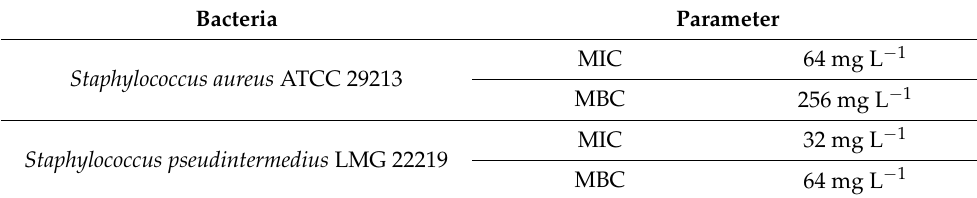
Table 1. Values of MIC and MBC for Staphylococci towards DHAB.